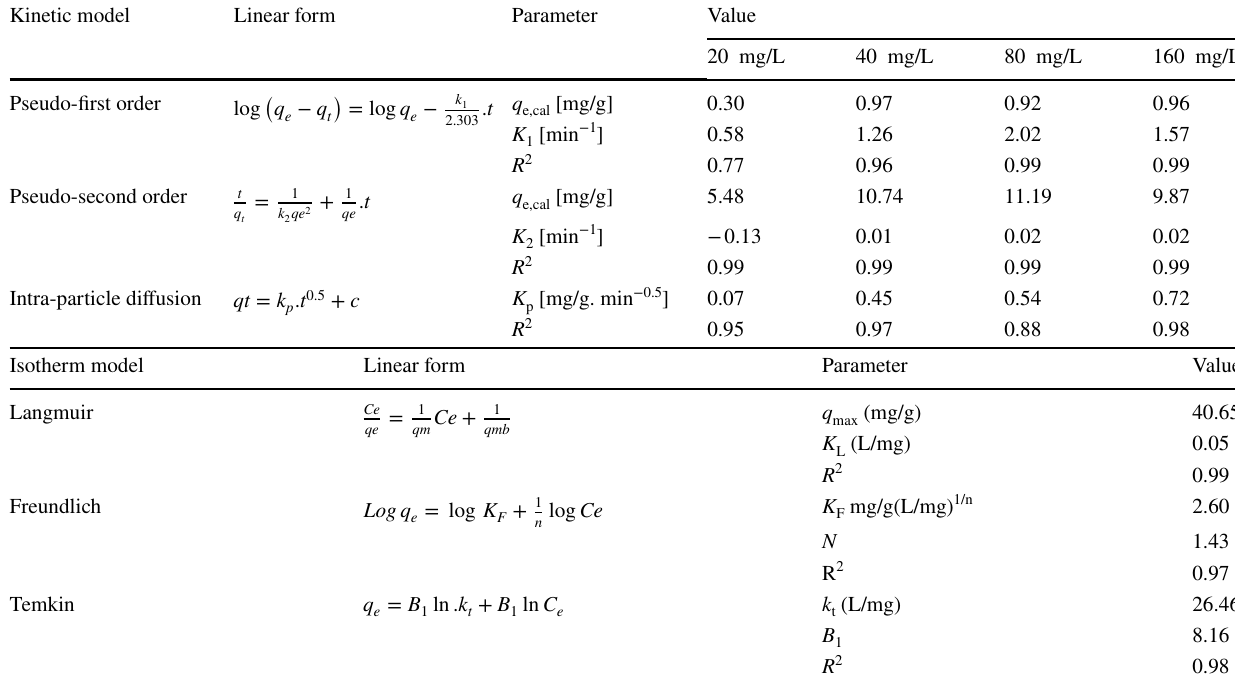
Table 6 The kinetic and isotherm parameters fitted for RR-141 removal using γ -Al